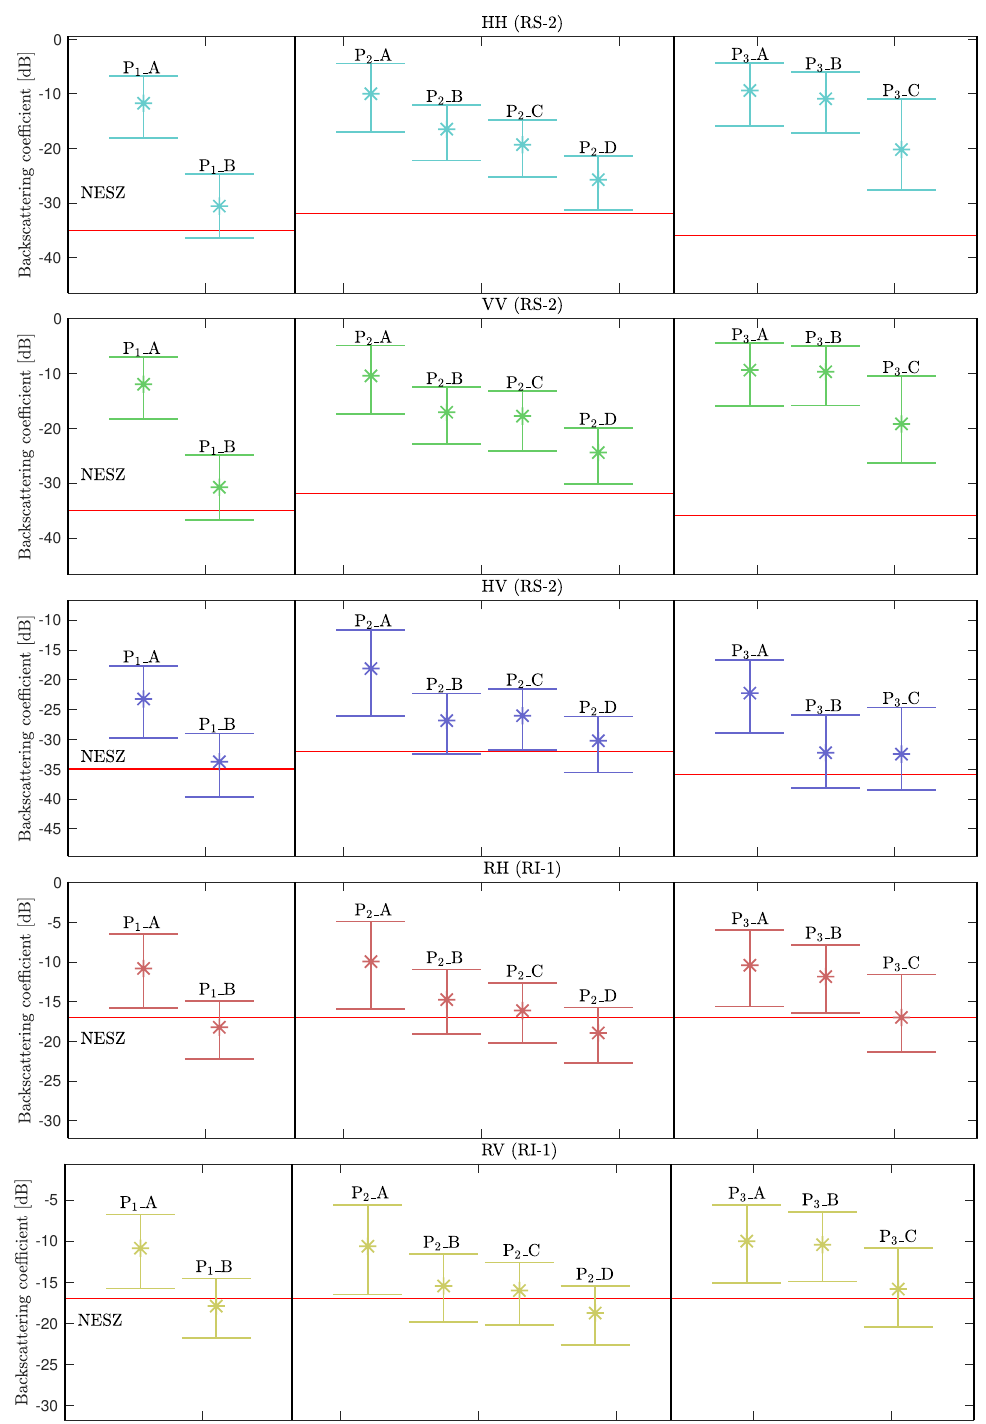
Figure 6. Signal-to-noise analysis of the backscattering intensity coefficients of the HH, VV, and HV for RS-2, and RH and RV for RI-1 for the investigated sea ice types. The 50th percentile is indicated by a star. The top and bottom horizontal continuous lines represent the 95th percentile and 5th percentile for the intensities, respectively. The red line represents NESZ. The y-axis represents the backscattering intensity coefficient, while the different sea ice types (i.e., ROIs) are aligned along the x-axis sorted by scene pair